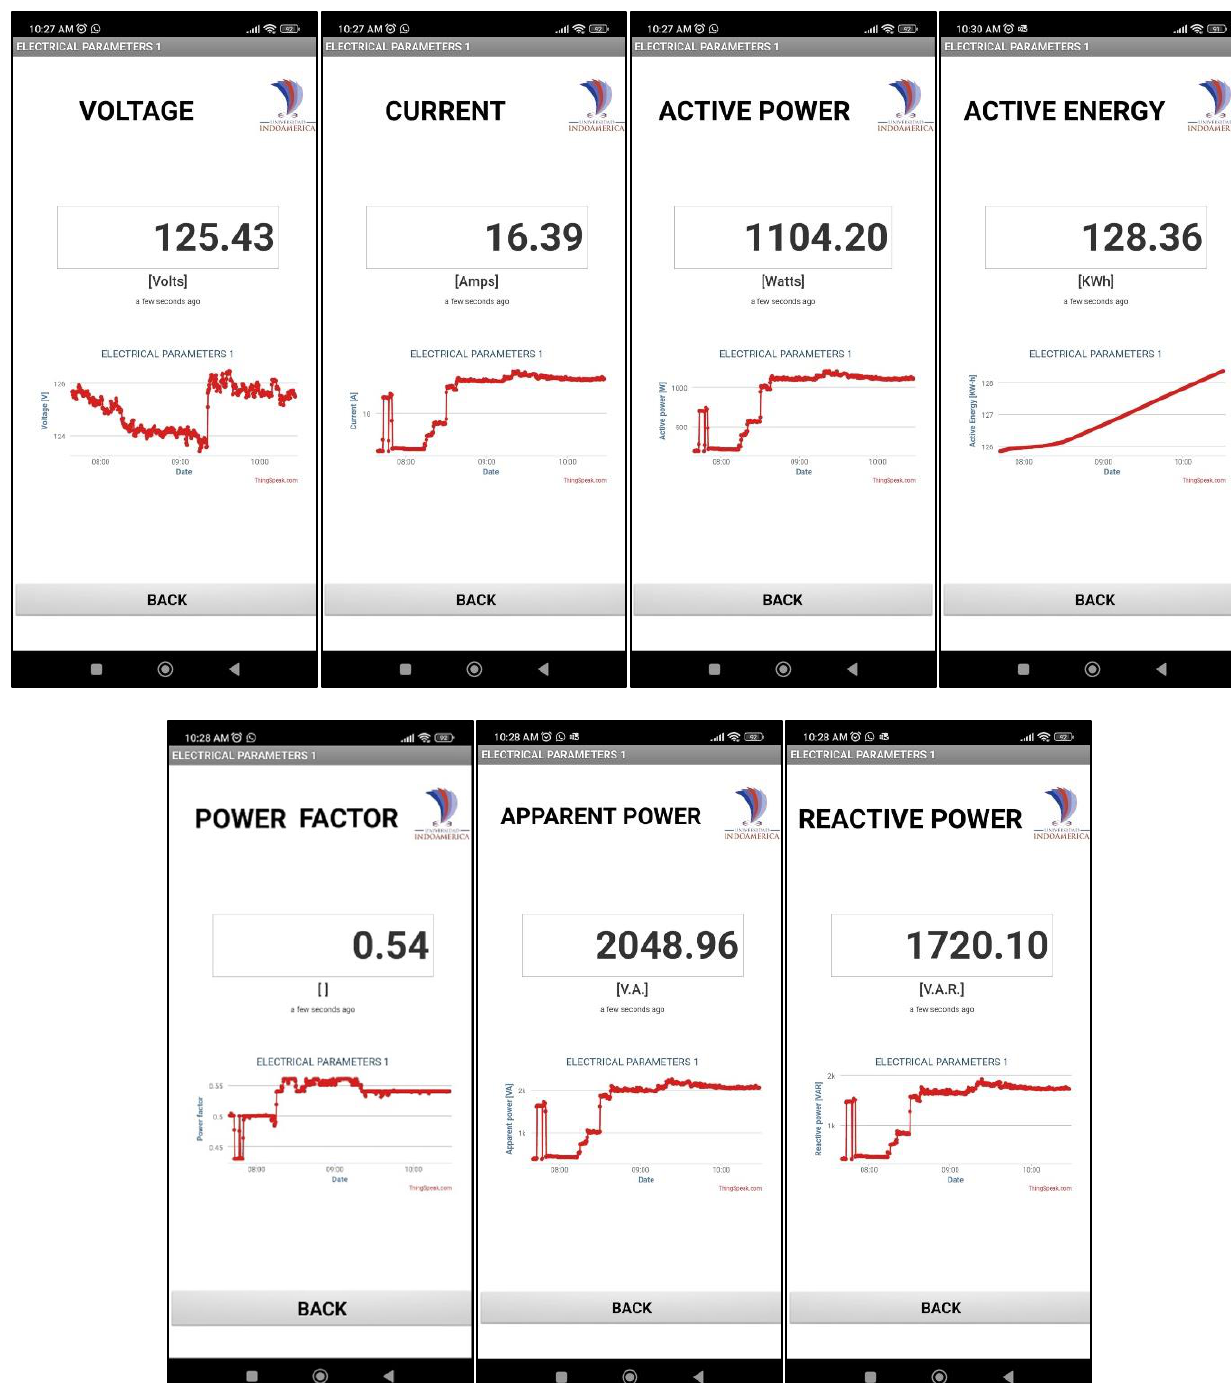
Figure 13. Screenshots of the mobile application for remote monitoring of electrical parameters.